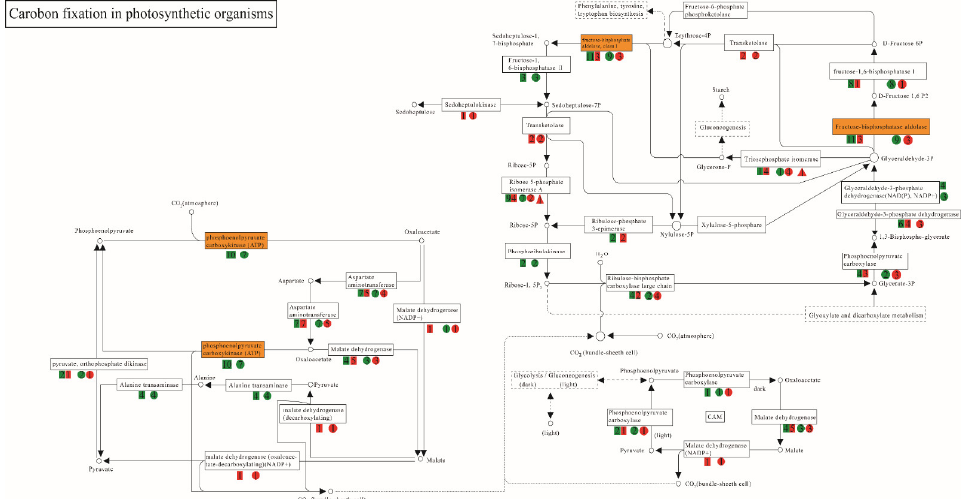
Figure A5. DEGs in carbon fixation. Squares indicate gall vs. LWG.; circles indicate gall vs. LNG; triangles indicate LNG vs. LWG. Red color represents up-regulation and green color represents down-regulation. The numbers within shaded shapes indicate the number of genes. There were 51 genes up-regulated and 100 genes down-regulated based on the comparison between gall vs. LWG, 46 genes up-regulated and 81 genes down-regulated based on the comparison between gall vs. LNG, two genes up-regulated based on the comparison between LNG vs. LWG. The genes encoding the first enzyme (phosphoenolpyruvate carboxykinase) in the reaction of transporting CO 2 into cells and the enzyme fructose-bisphosphate aldolase were strongly